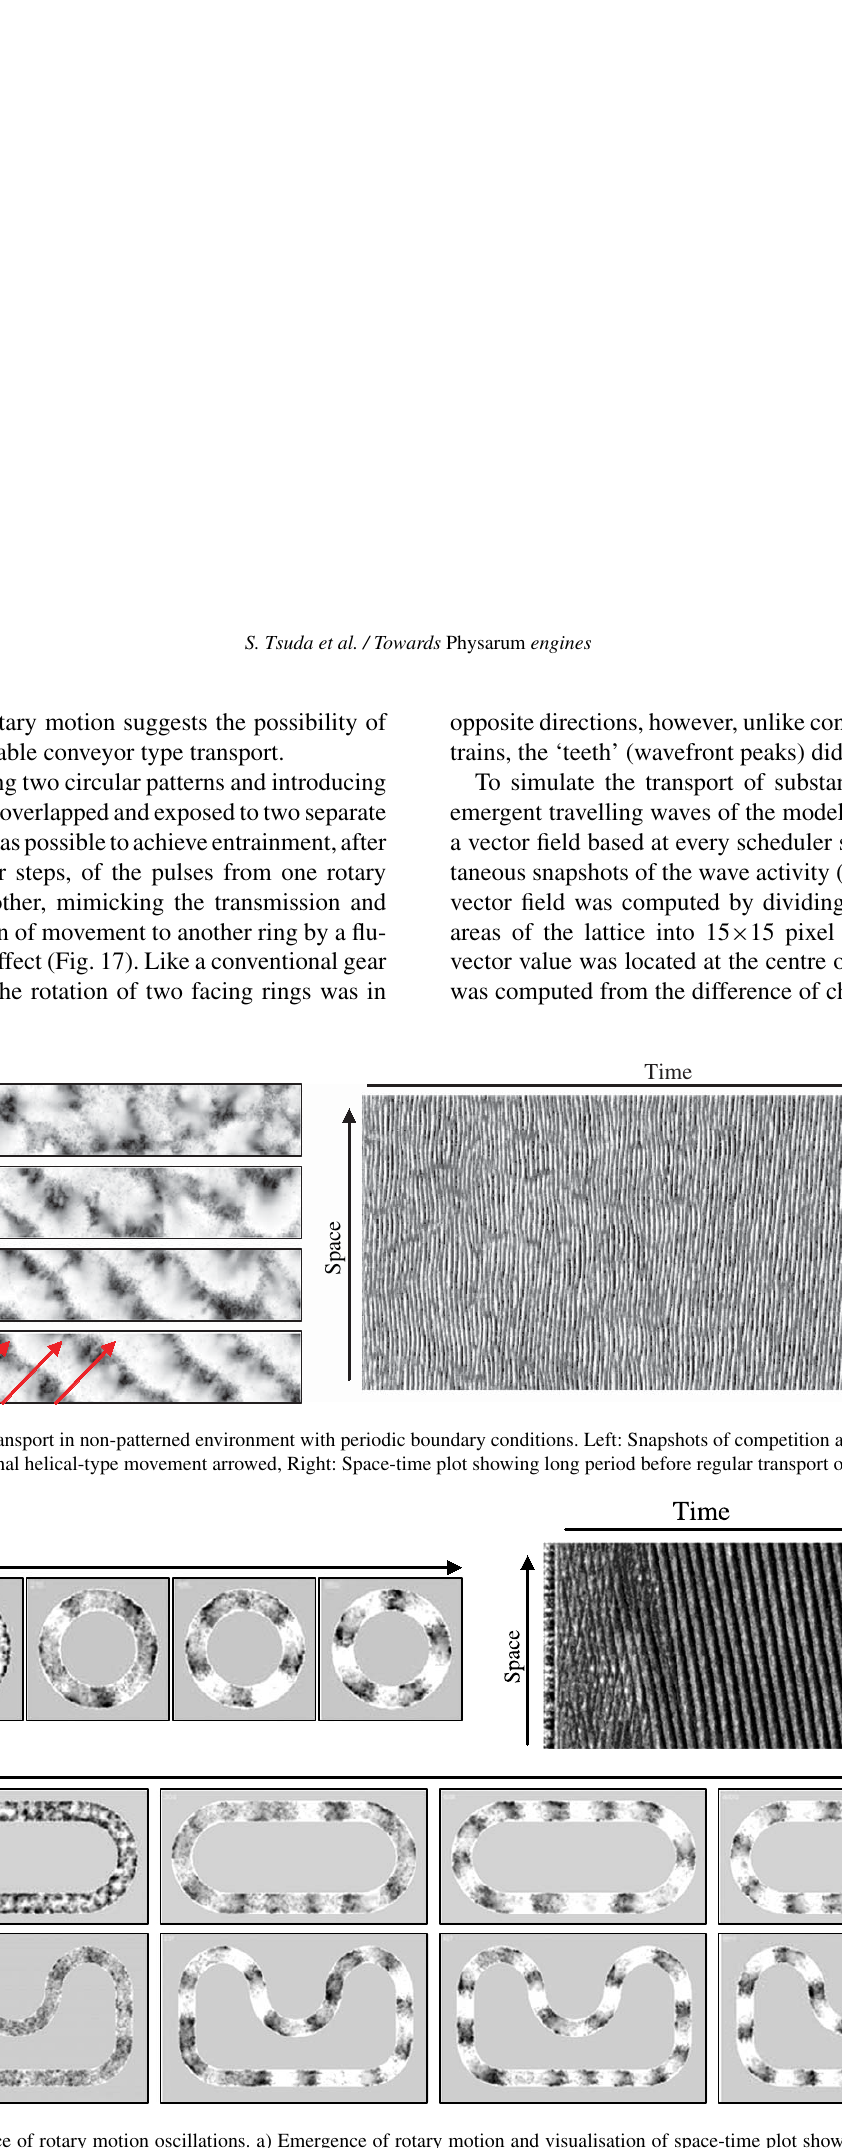
Fig. 16. Emergence of rotary motion oscillations. a) Emergence of rotary motion and visualisation of space-time plot showing regular motor pulses. Space time plot was created by recording 360 points inside the vacant track of the circle, b) Tracked rotary movement from a combination of circular and straight regions, c) Conveyor type motion from a more tortuous looped